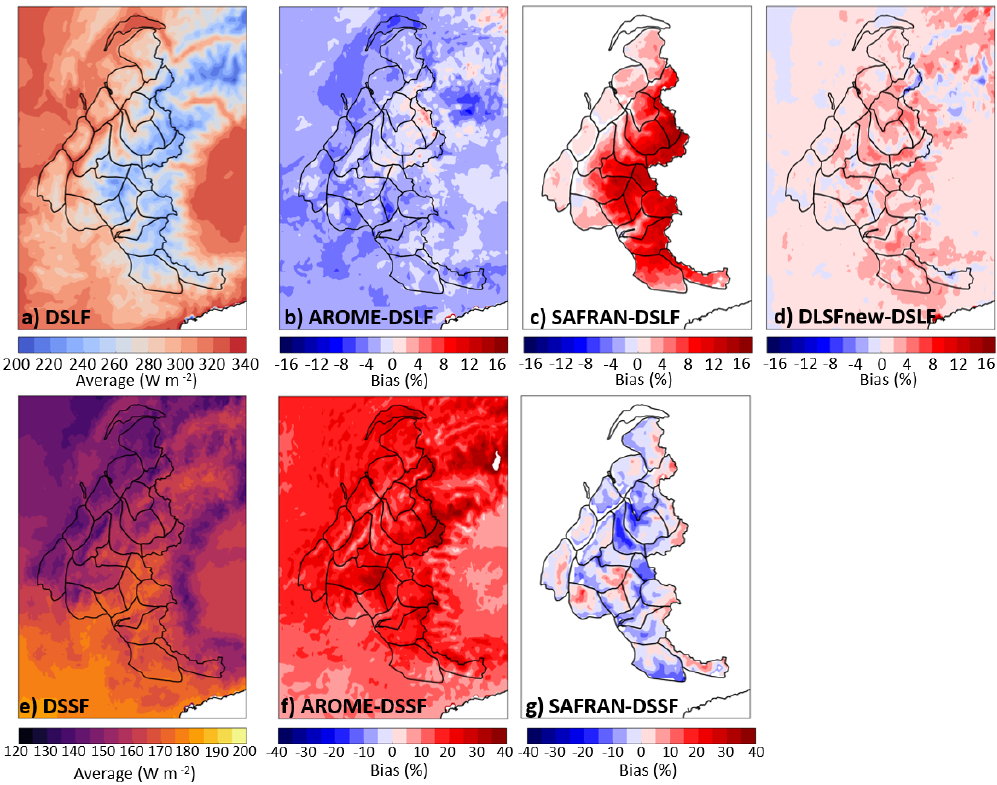
Figure 5. (a) Average of the DSLF from 1 August 2010 to 31 July 2014 in the French Alps, and relative difference with the DSLF for (b) AROME, (c) SAFRAN and (d) DSLFnew. (e) Average of the DSSF, and relative difference with the DSSF for (f) AROME and (g)